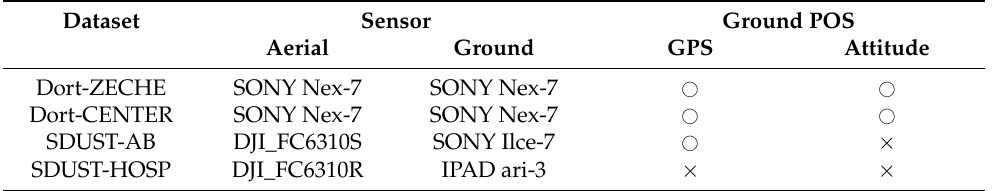
Table 1. Description of the four datasets used for evaluation.